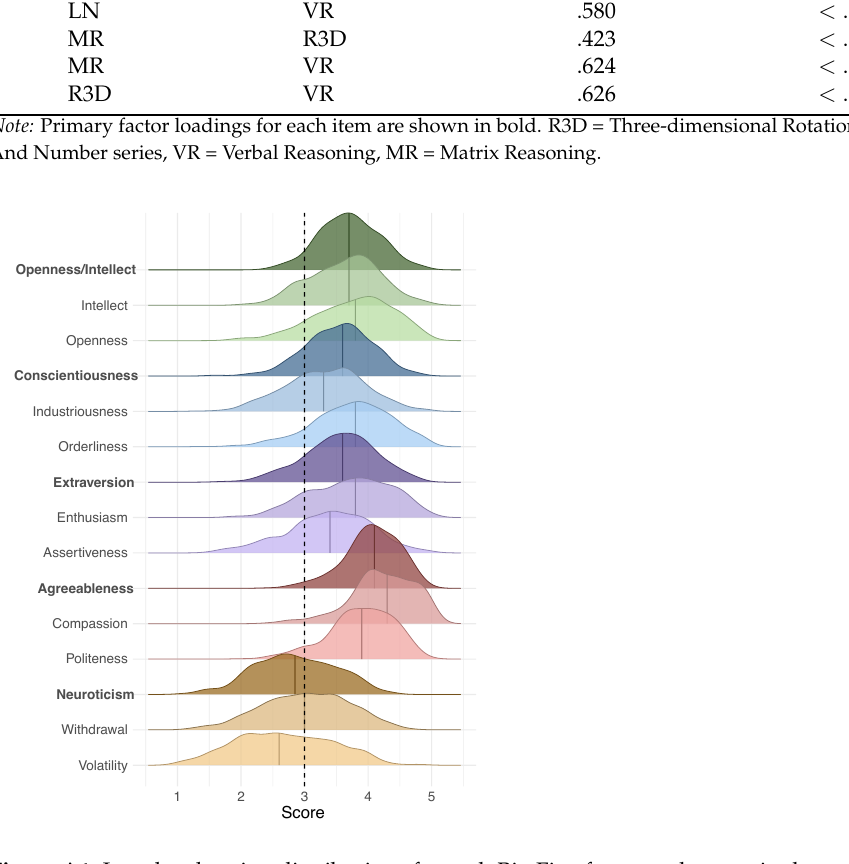
Figure A1. Joy plot showing distributions for each Big Five factor and aspect in the current sample ( N = 480). Dashed line represents theoretical mean, and individual solid lines represent medians for each factor or